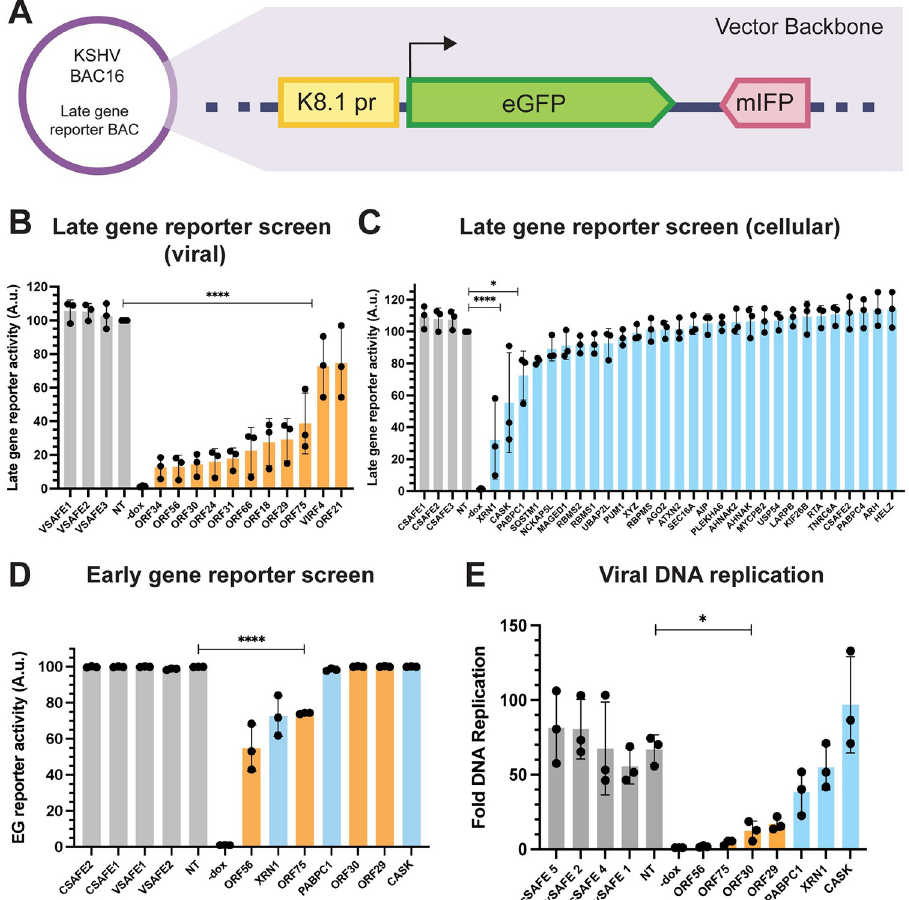
Fig 2. Functional analysis of ORF18-interacting proteins. (A) Schematic of the late gene reporter virus used to measure late gene expression by flow cytometry. The reporter construct was cloned into a region of the vector backbone of the KSHV BAC16. The K8.1 late gene promoter drives expression of eGFP, and mIFP is constitutively expressed from the EF-1a promoter. (B) Late gene reporter signal for CRISPR knockouts of viral genes at 72 h post reactivation. Knockouts were normalized against the non-targeting control (NT) within each replicate. Data are from three independent biological replicates, **** = P < 0.0001. P values calculated from ordinary one-way ANOVA test. (C) Late gene reporter signal for CRISPR knockouts of cellular genes at 72 h post reactivation. Knockouts were normalized against the non-targeting control (NT) within each replicate. Data are from three independent biological replicates, **** = P < 0.0001, * = P < 0.05. P values calculated from ordinary one-way ANOVA test. (D) Early gene reporter signal for CRISPR knockouts of viral and cellular genes at 48 h post reactivation. Knockouts were normalized against the non-targeting control (NT) within each replicate. Data are from three independent biological replicates, **** = P < 0.0001. P values calculated from ordinary one-way ANOVA test. (E) Viral DNA replication was measured using qPCR to compare reactivated to non-reactivated cells for each CRISPR knockout line. Data are from three independent biological replicates, * = P < 0.05. P values calculated from ordinary one-way ANOVA test.